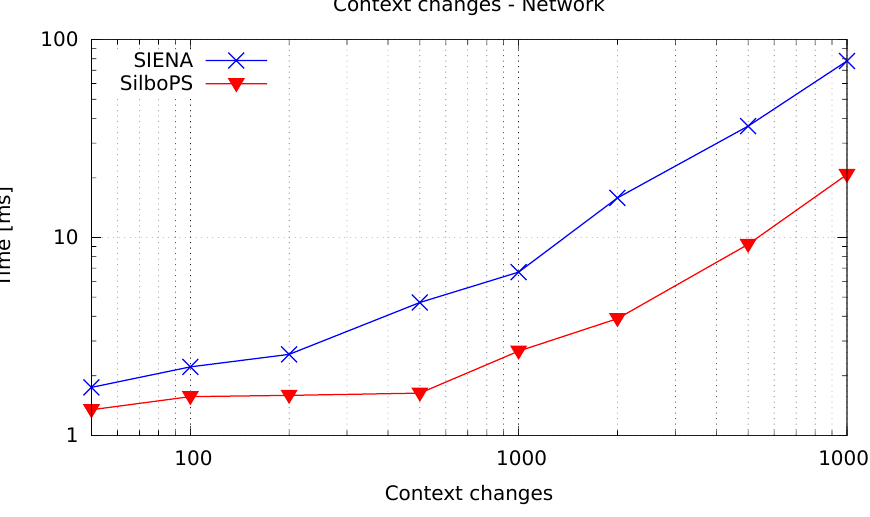
Figure 10. Time required for changing the context in a 5-broker network with 1 publisher and 100 subscribers